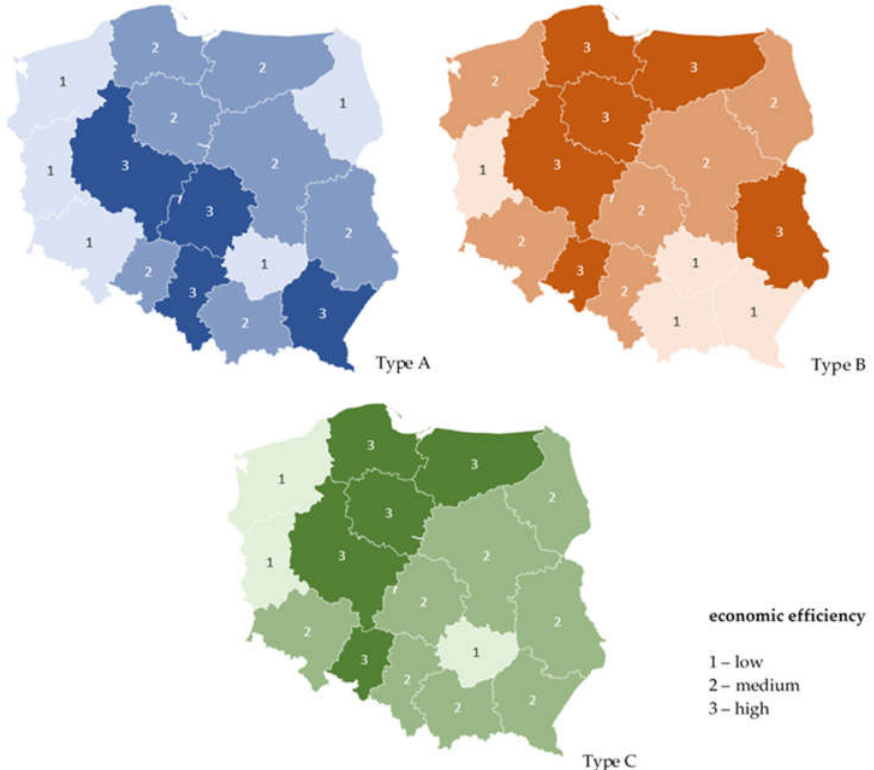
Figure 3. The division of Poland into regions, homogeneous in terms of economic efficiency of electricity production using photovoltaic systems, depending on the farm type.